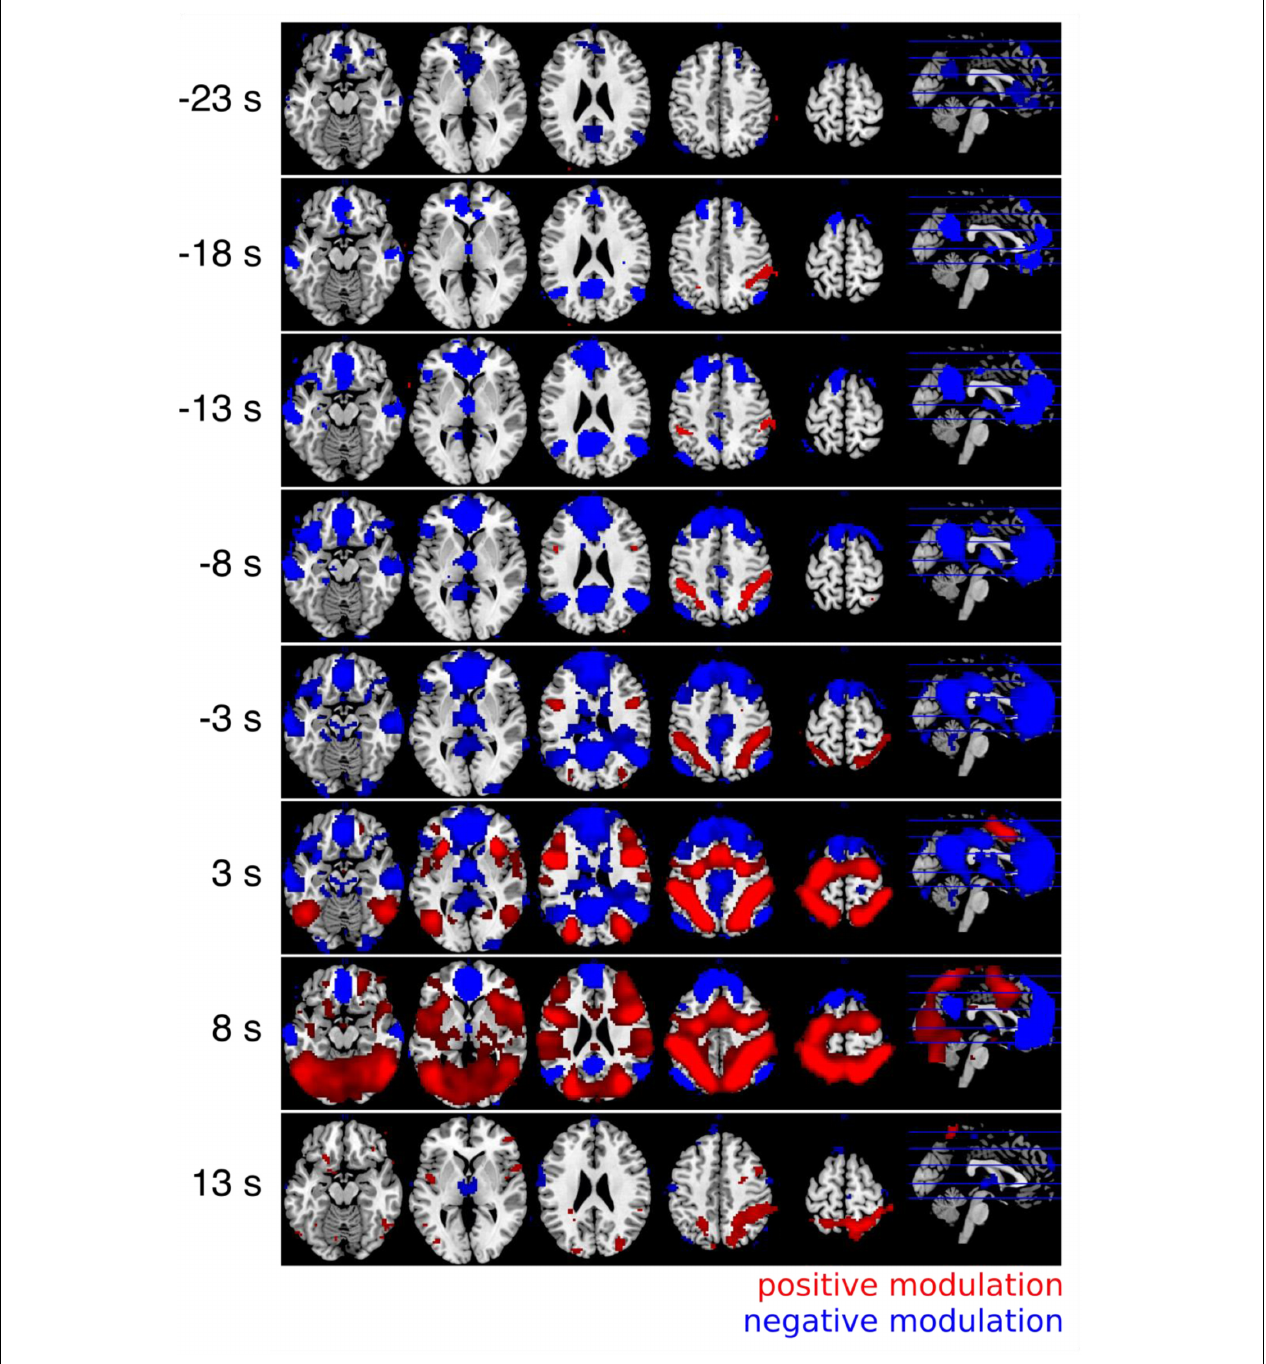
FIGURE 5 | Results of the cross correlation analysis between the (time shifted) fMRI signal and the response times. The Fisher-Z normalized correlation maps with positive lags (3 and 8 s) are very similar to the GLM results ( Figure 3 ). The negative correlations can be observed very early up to 18 s before the button presses (all p < 0.05, FWE corrected at the voxel level). Always five different time lags were combined with t-contrasts and labeled with the mean time lag (i.e., results of the time lags between 1 and 5 s are combined and labeled with a time lag of 3 s in the